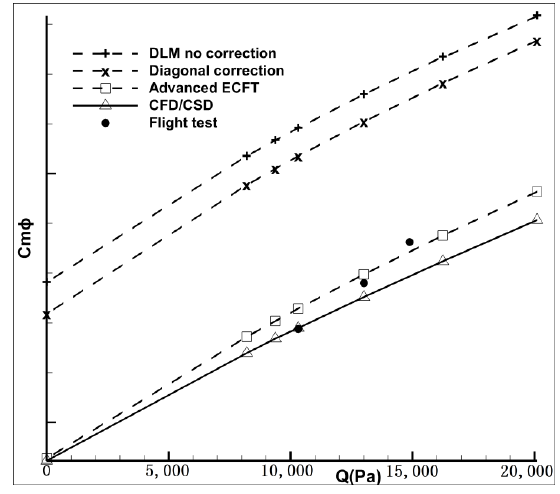
Figure 14. Elastic C m ϕ at different dynamic pressures.